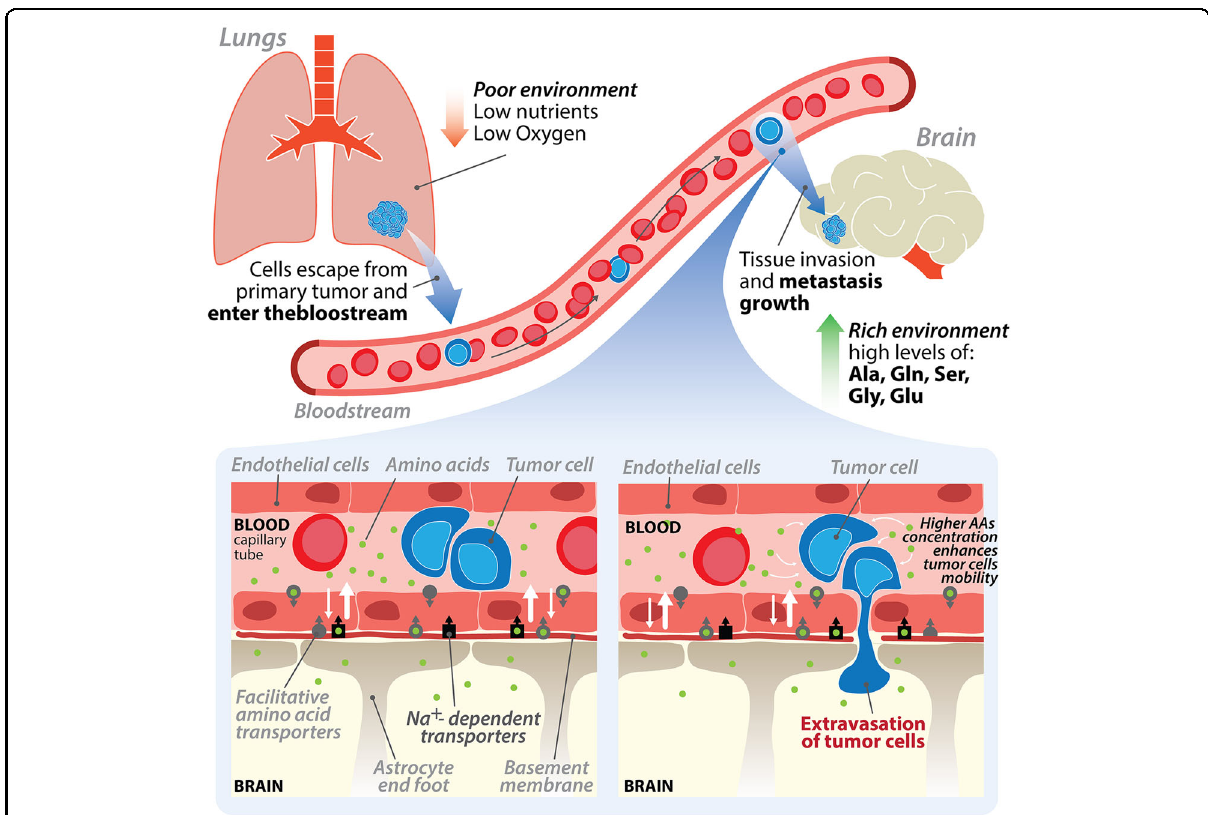
Fig. 7 Brain-to-blood ef fl ux model. The scheme depicts the hypothesis that cancer cell migration from the primary tumor site and invasion of the brain parenchyma is prompted by the high levels of amino acids, including serine and glycine, whose effect on cell motility was shown in this